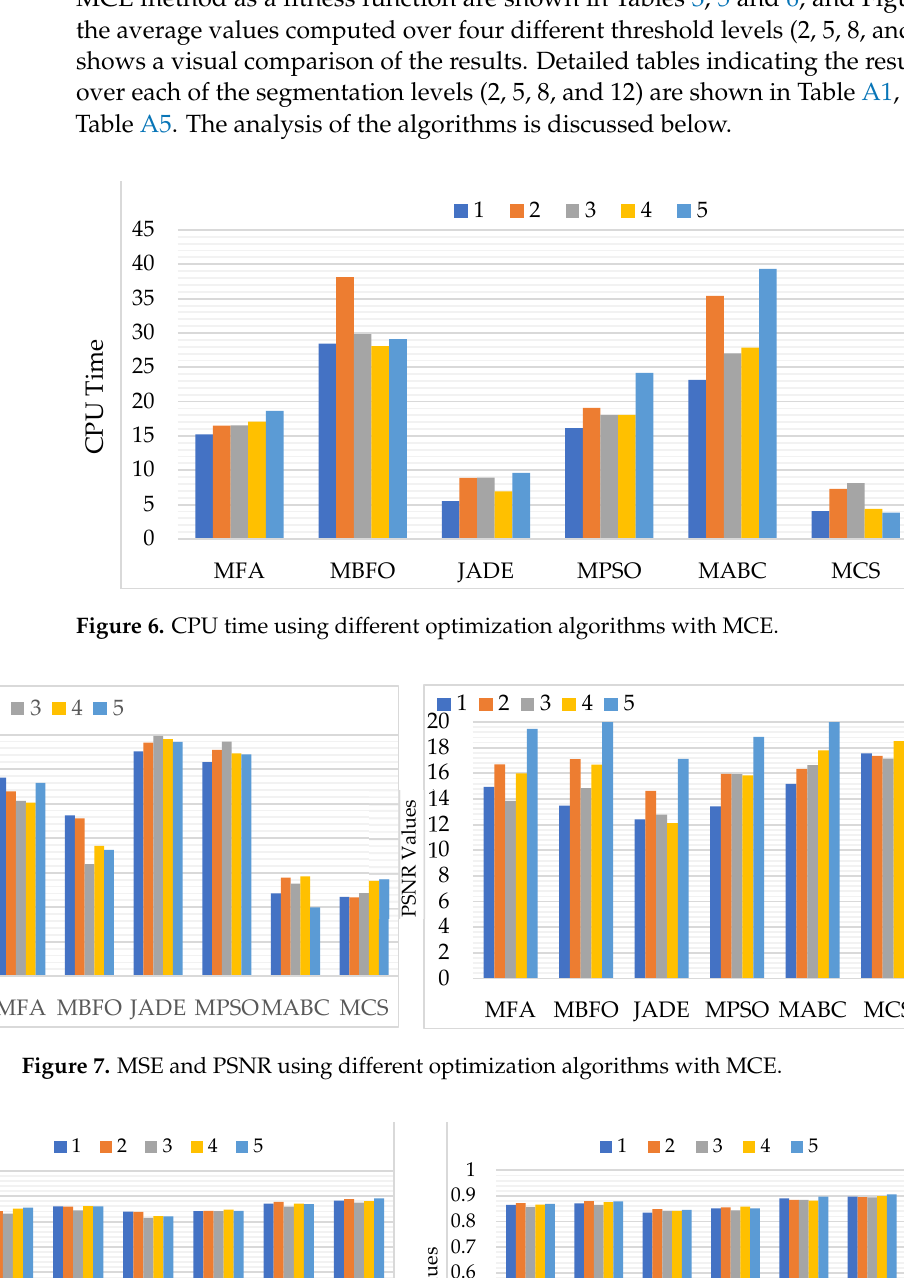
Table 5. MSE and PSNR using different optimization algorithms with minimum cross entropy.